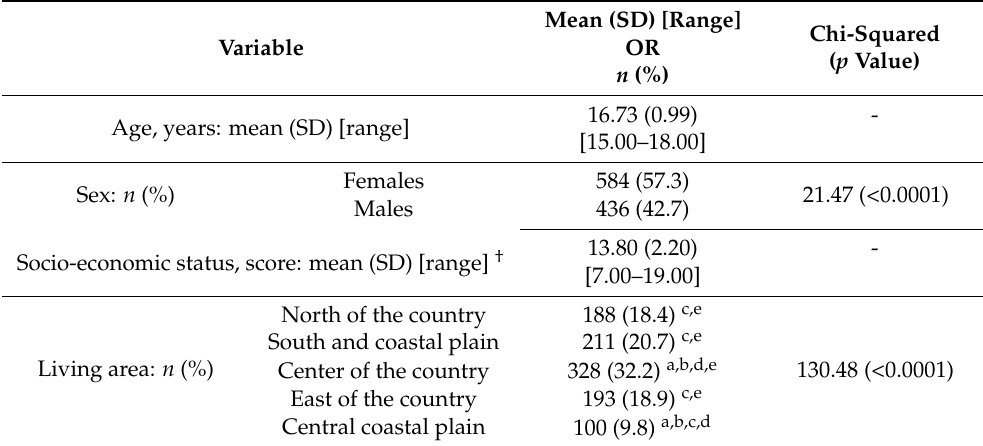
Table 1. Sociodemographic characteristics of study participants ( n =